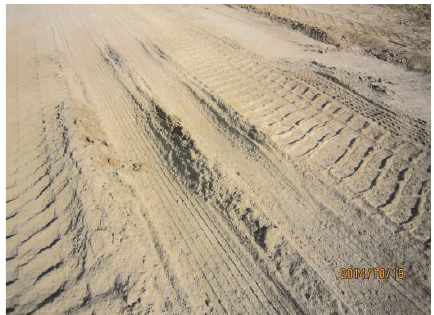
Figure 12: Surface condition of base layer.